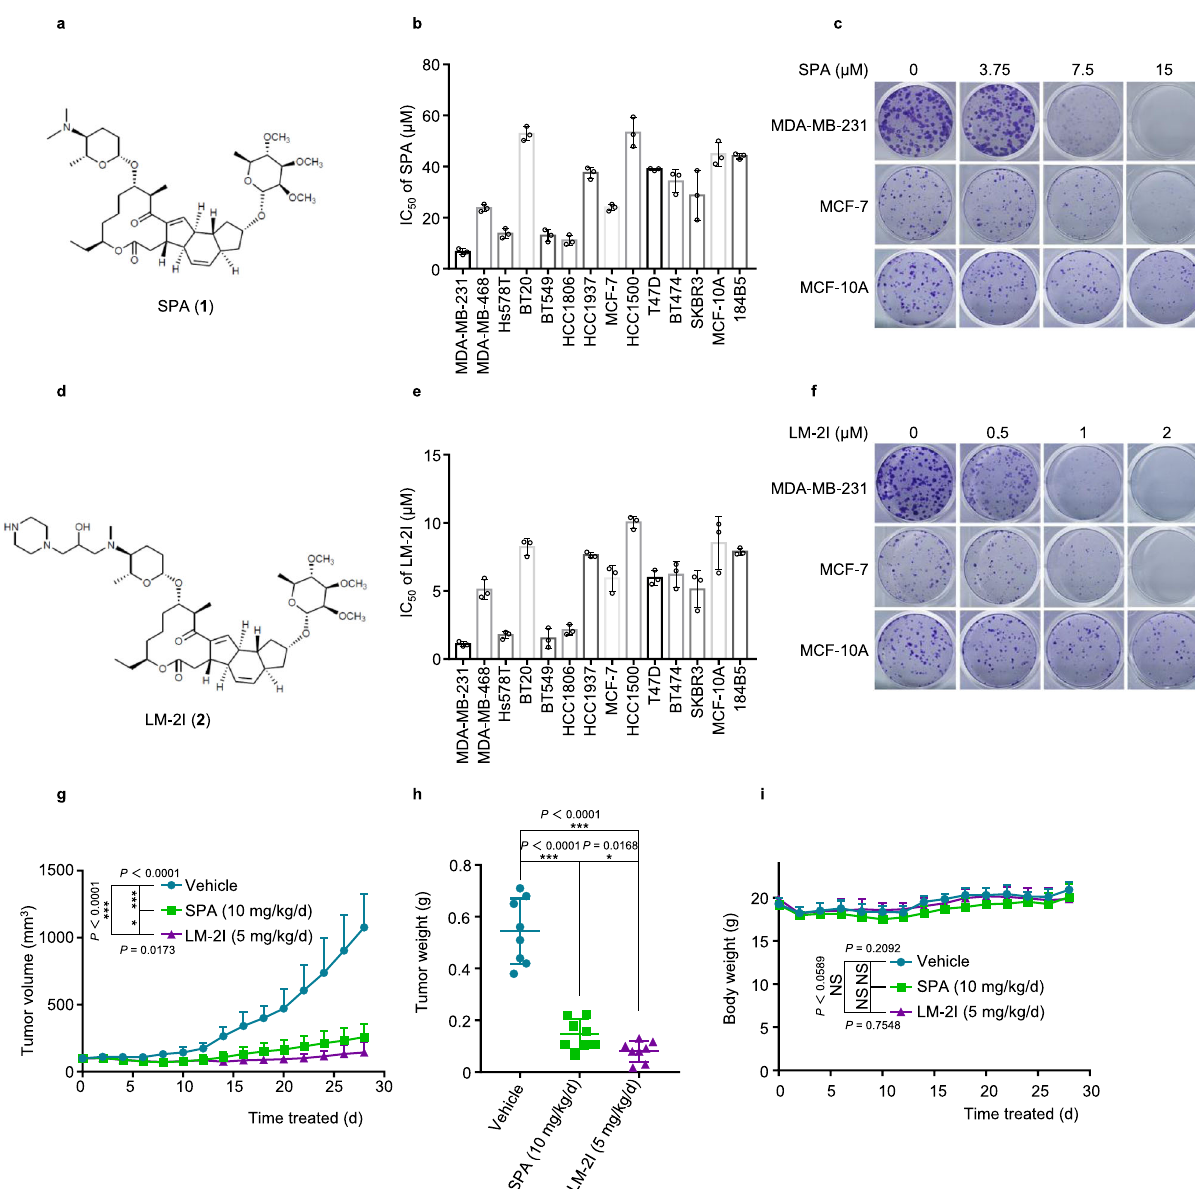
Fig. 1 SPA and its derivative LM-2I inhibit breast cancer proliferation and growth. a Chemical structures of SPA ( 1 ). b Crystal violet assay for the effects of SPA on breast cancer cell proliferation. IC 50 values were calculated with SPSS 18.0 (mean±s.d., n = 3 biologically independent experiments). c Representative microscope images of colony formation for different breast cancer cell lines treated with SPA. Scale bars are 40 µ M. d Chemical structures of LM-2I ( 2 ). e Crystal violet assay for the effects of LM-2I on breast cancer cell proliferation. IC 50 values were calculated with SPSS 18.0 (mean±s.d., n = 3 biologically independent experiments). f Representative microscope images of colony formation for different breast cancer cell lines treated with LM-2I. Scale bars are 40 µ M. MDA-MB-231 cells were inoculated subcutaneously into the right fl ank of nu/nu female mice. When the average tumor size reached about 100mm 3 , mice were treated with ether vehicle, SPA (10mg/kg/day) or LM-2I (5mg/kg/day). Tumor sizes ( g ) and mouse body weight ( i ) were measured every 2 days. 28 days later, mice were sacri fi ced and tumors were dissected and weighted ( h ). Data represent mean±s.d. ( n = 8 mice per group). * P <0.05, *** P <0.001, NS: not signi fi cant ( P >0.05) from two-tailed unpaired Student ’ s t tests.Source data are provided as a Source Data fi band precipitated by Biotin-SPA in MCF-7 cell lysates was ASS1 (Fig. 2f). Fluorescent staining of MCF-7 (Fig. 2g), MDA-MB-231